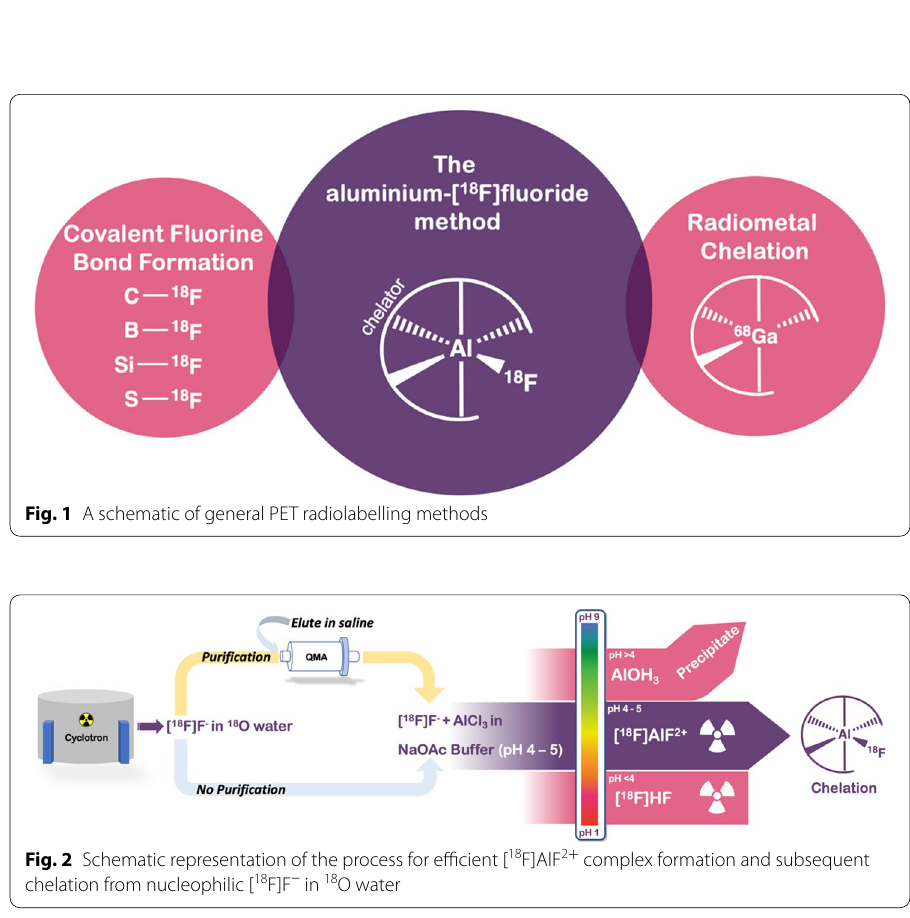
Table 1 Examples of [ 18 F]F − purification by QMA SPE cartridge